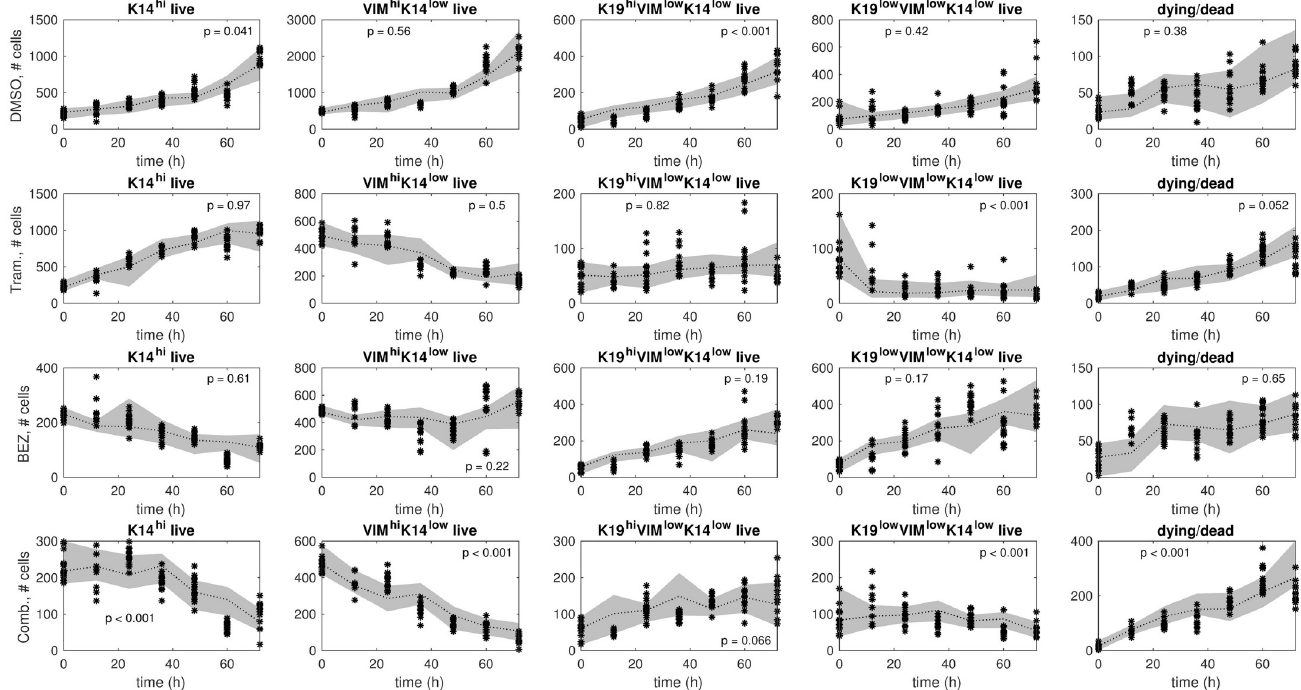
Fig 2. Ensemble model predictions in comparison to training data. The training samples (black stars) and predictions by the model ensemble (gray bands) are shown for each treatment condition: DMSO (row 1), Trametinib (row 2), BEZ235 (row 3), and Trametinib+BEZ235 (row 4). The model ensemble is a collection of models that were identified from the training data via resampling residuals bootstrap [30] for each treatment condition. In each plot, we show a 95% confidence interval (gray band) around the median (black dotted line) of the ensemble model predictions. Higher p-values indicate better consistency between predictions and training data over the time horizon (12h, 24h, ... ,